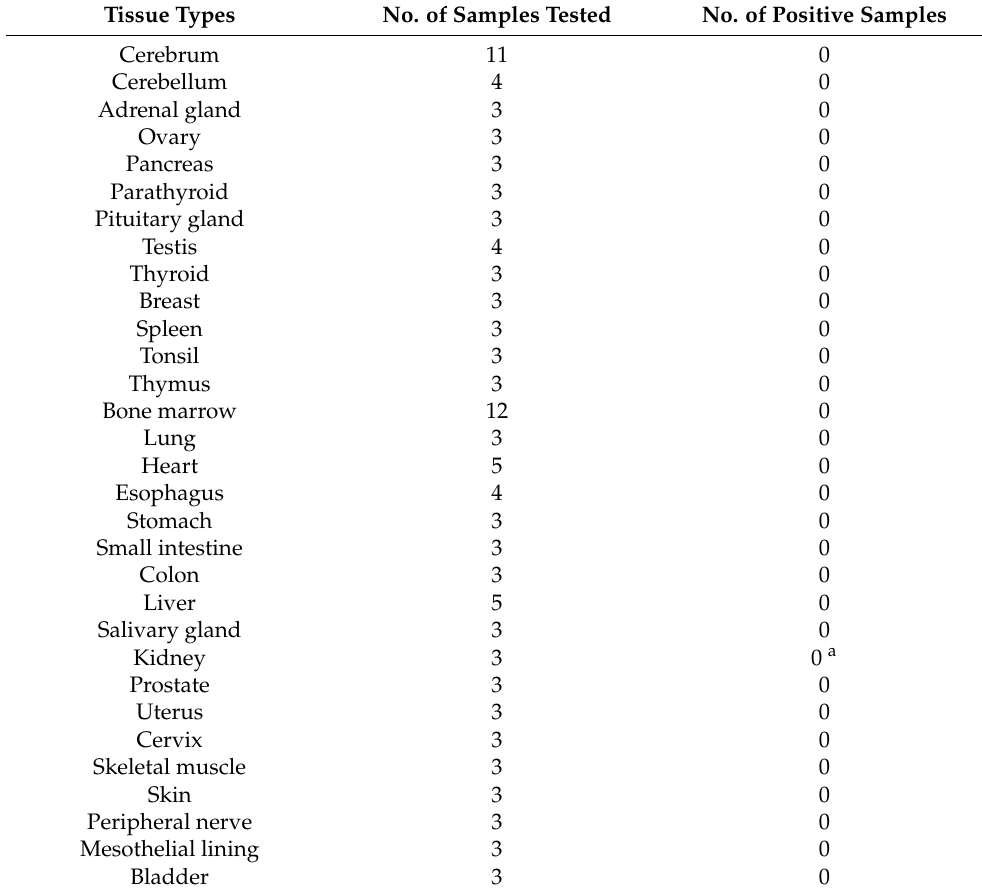
Table 3. IHC testing results with IDH1 R132H (MRQ-67) on normal